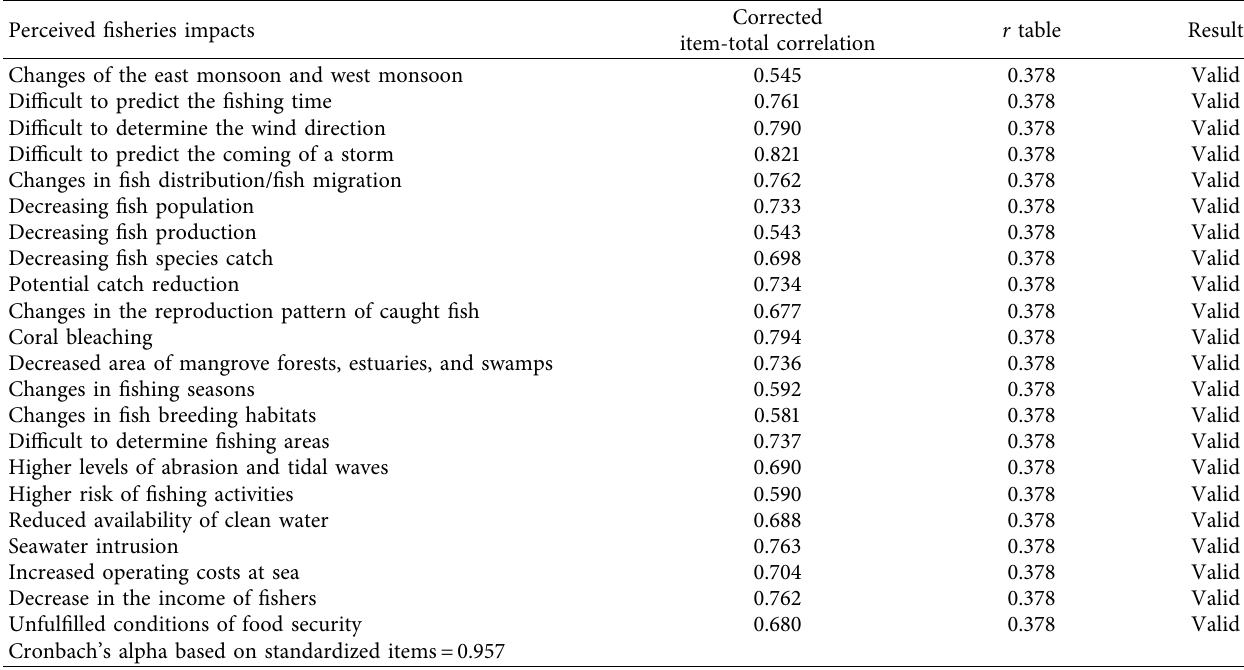
Table 2: Validity and reliability results of climate change impact perceptions.